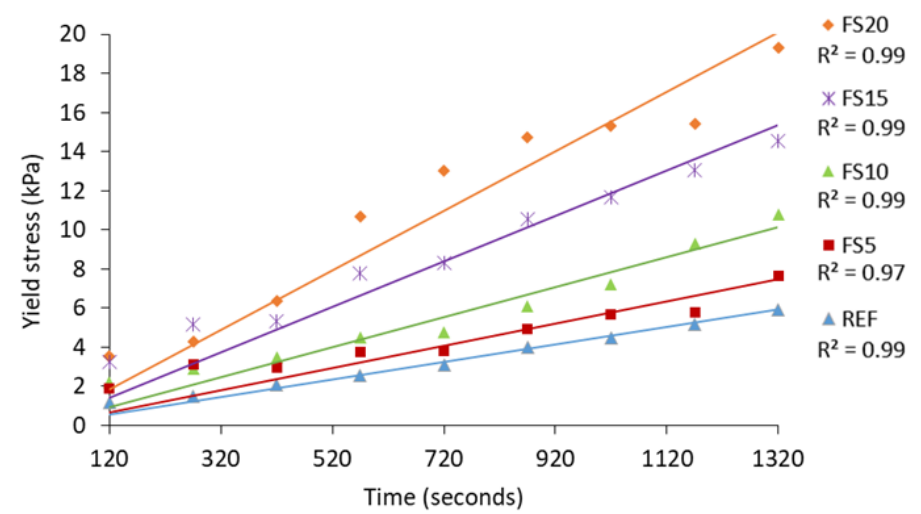
Figure 11. Yield stress evolution of mortars with time.